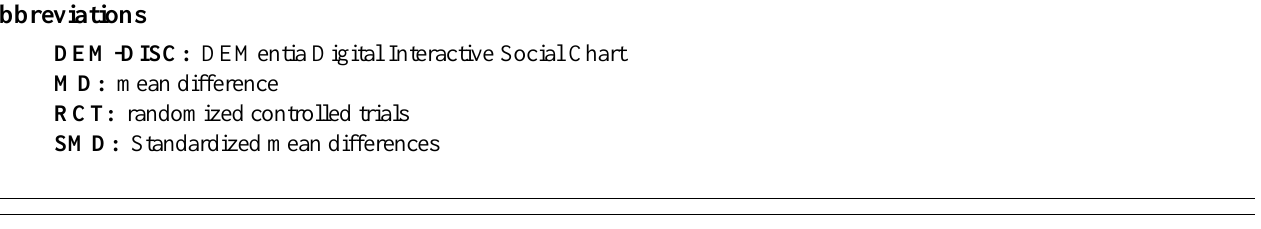
Abbreviations DEM-DISC: DEMentia Digital Interactive Social Chart MD: mean difference RCT: randomized controlled trials SMD: Standardized mean